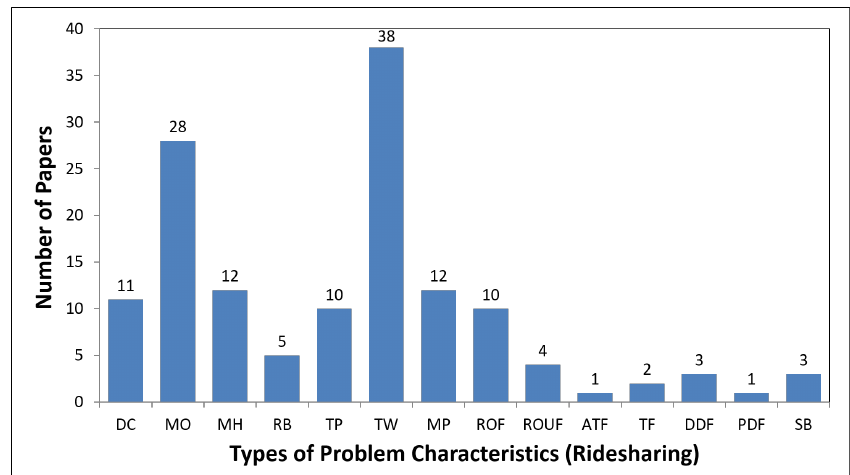
Figure 8. Distribution of Papers based on the Problem Characteristics: Ridesharing.